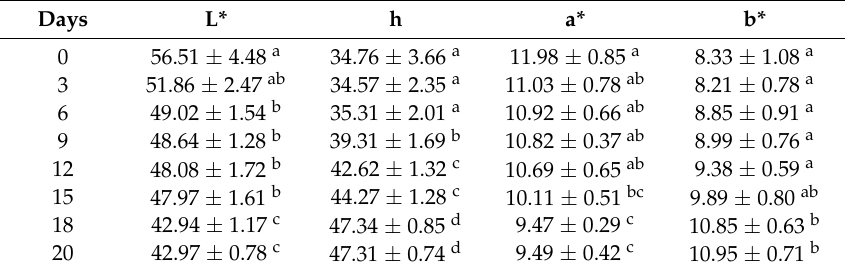
Table A4. Color parameters of smoked pork hams during refrigerator storage.